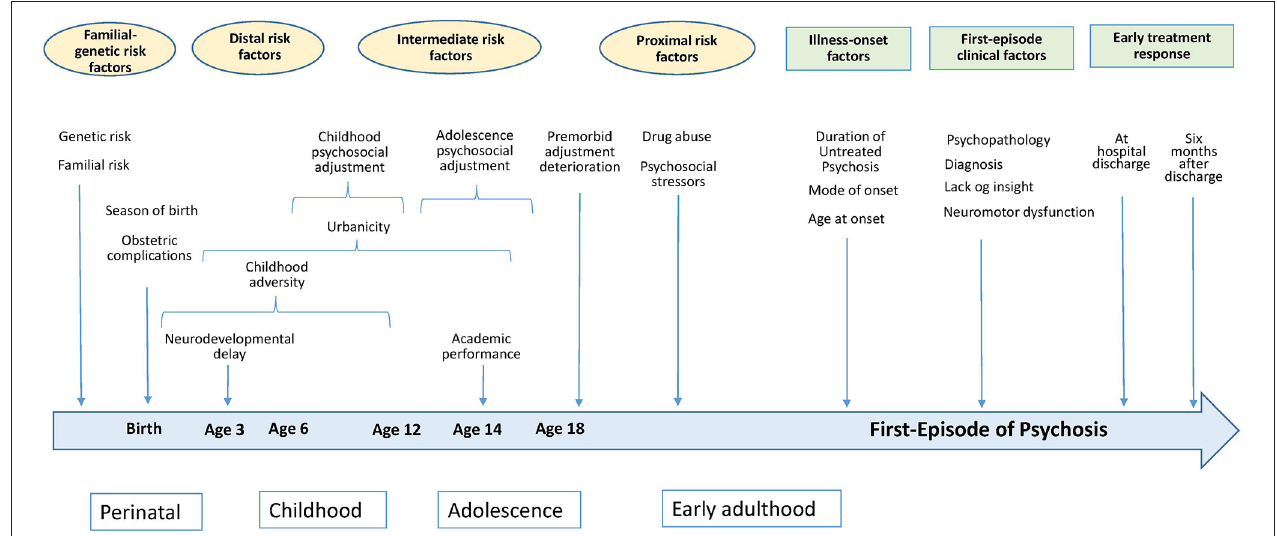
FIGURE 1 | A schematic time-line representation of baseline predictors of long-term outcomes of psychotic disorders.